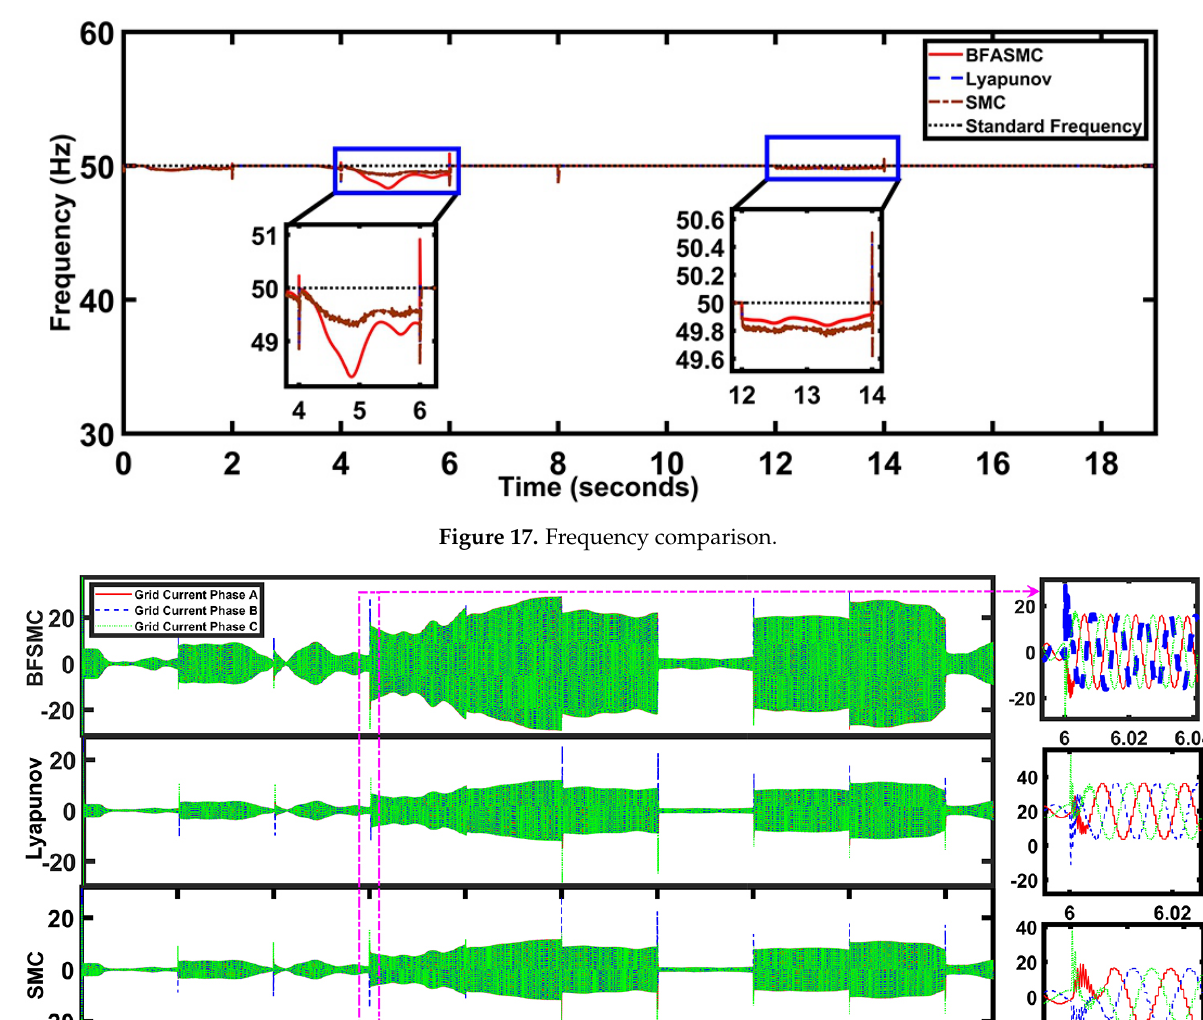
Figure 16. Grid voltage during grid-connected mode.